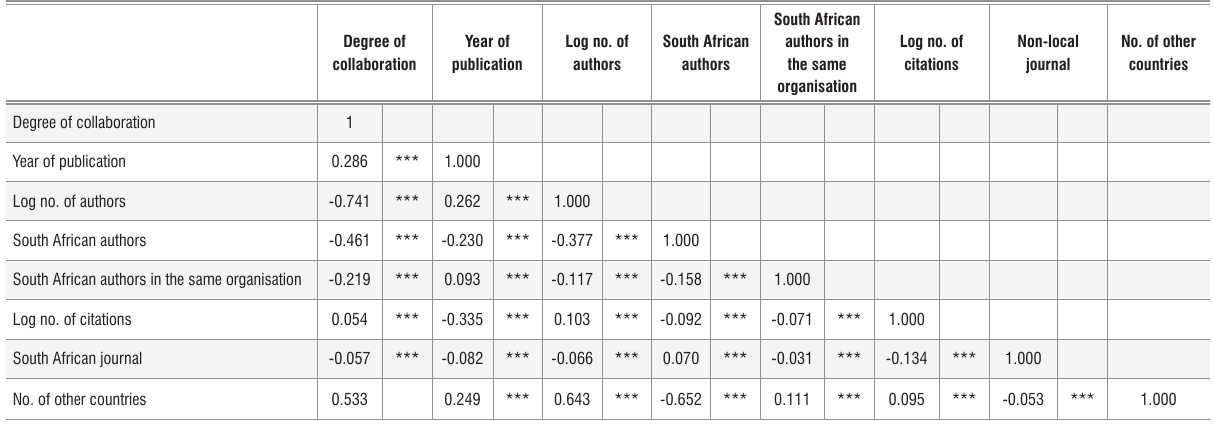
Degree of collaboration